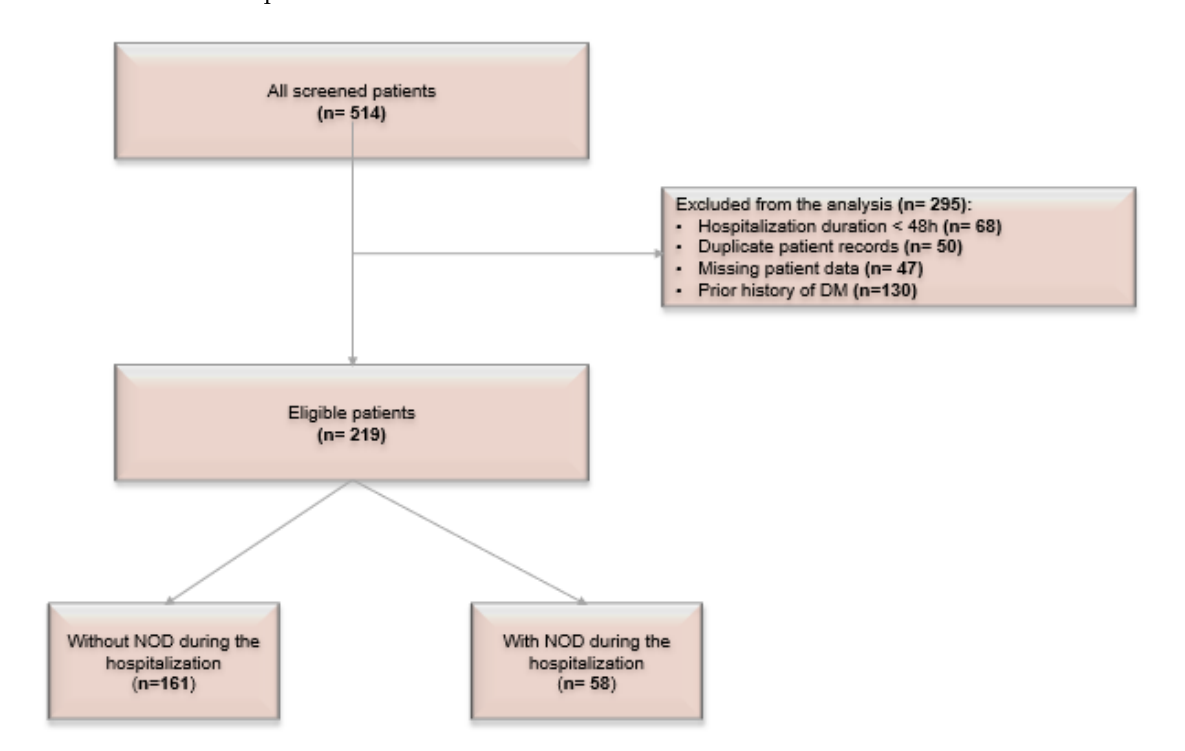
Table 1. Demographic and clinically relevant data of population. Characteristics